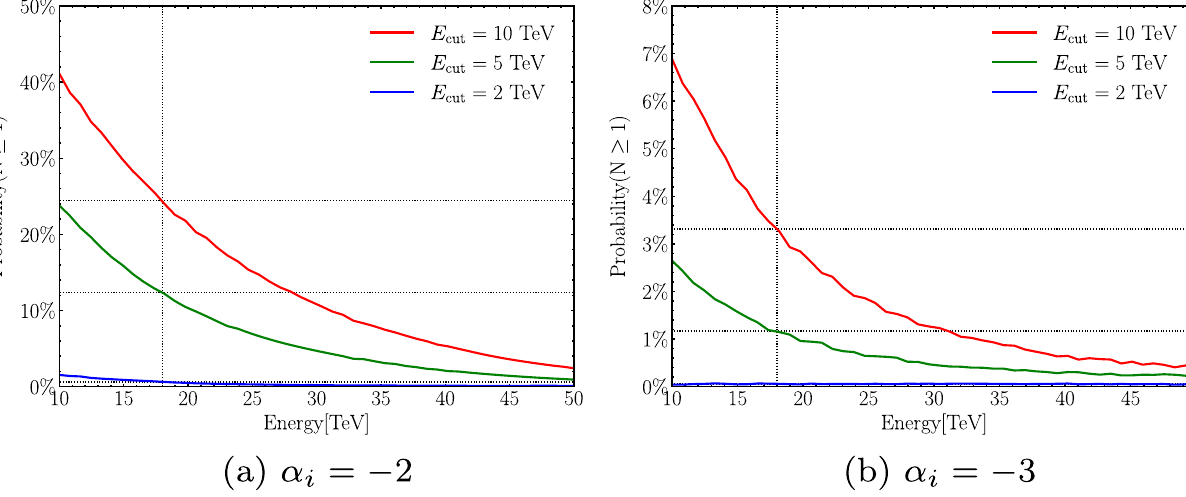
and the right panel shows the case of α i = − 3. The dotted vertical lines denote 18 TeV photons while the dotted horizontal lines denote probabilities of observing at least one photon of around 18